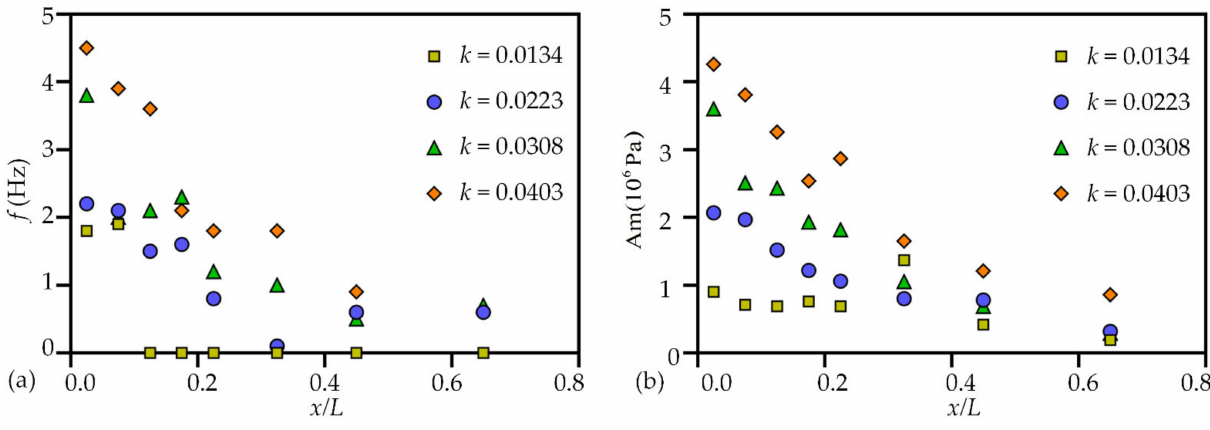
Figure 11. ( a ) Advantage frequency table shows that k = 0.0134; k = 0.0223; k = 0.0308; k = 0.0403, the main frequency of the characteristic points of the bottom of the stilling pool; ( b ) Marginal spectrum amplitude table shows the marginal spectral amplitude of the characteristic points on the bottom of the stilling pool when k = 0.0134; k = 0.0223; k = 0.0308; k =